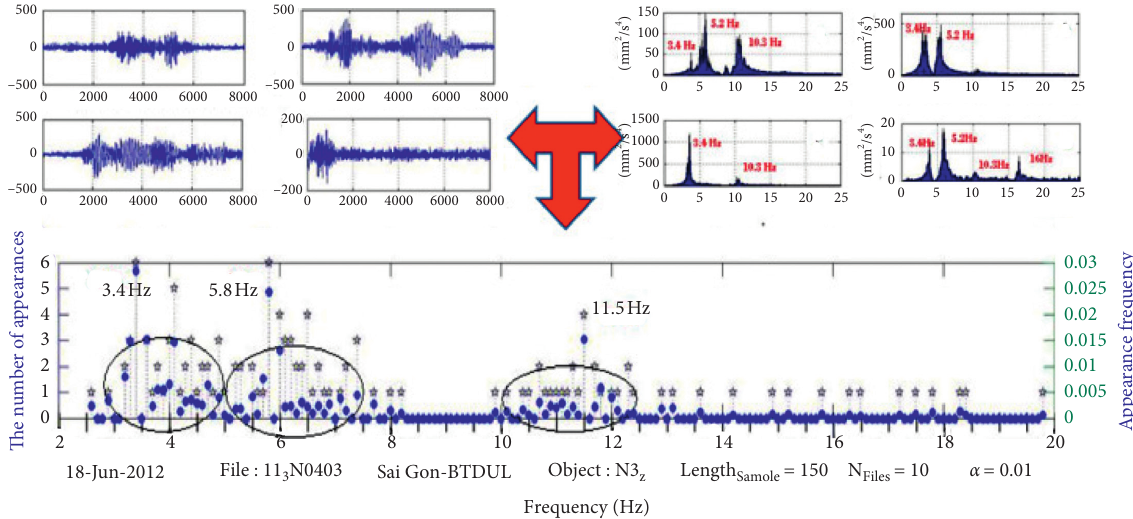
Figure 16: The construction process of representative power spectral density of Sai Gon Figure 18 or show two single vibration types concurrently including bending and torsion vibrations as shown by Figure 17 is a representative power spectral density of dif- Figure 19 of spans of Giong Ong To bridge. Bridges with ferent measurement times at the second span of Giong Ong To Moi bridge.